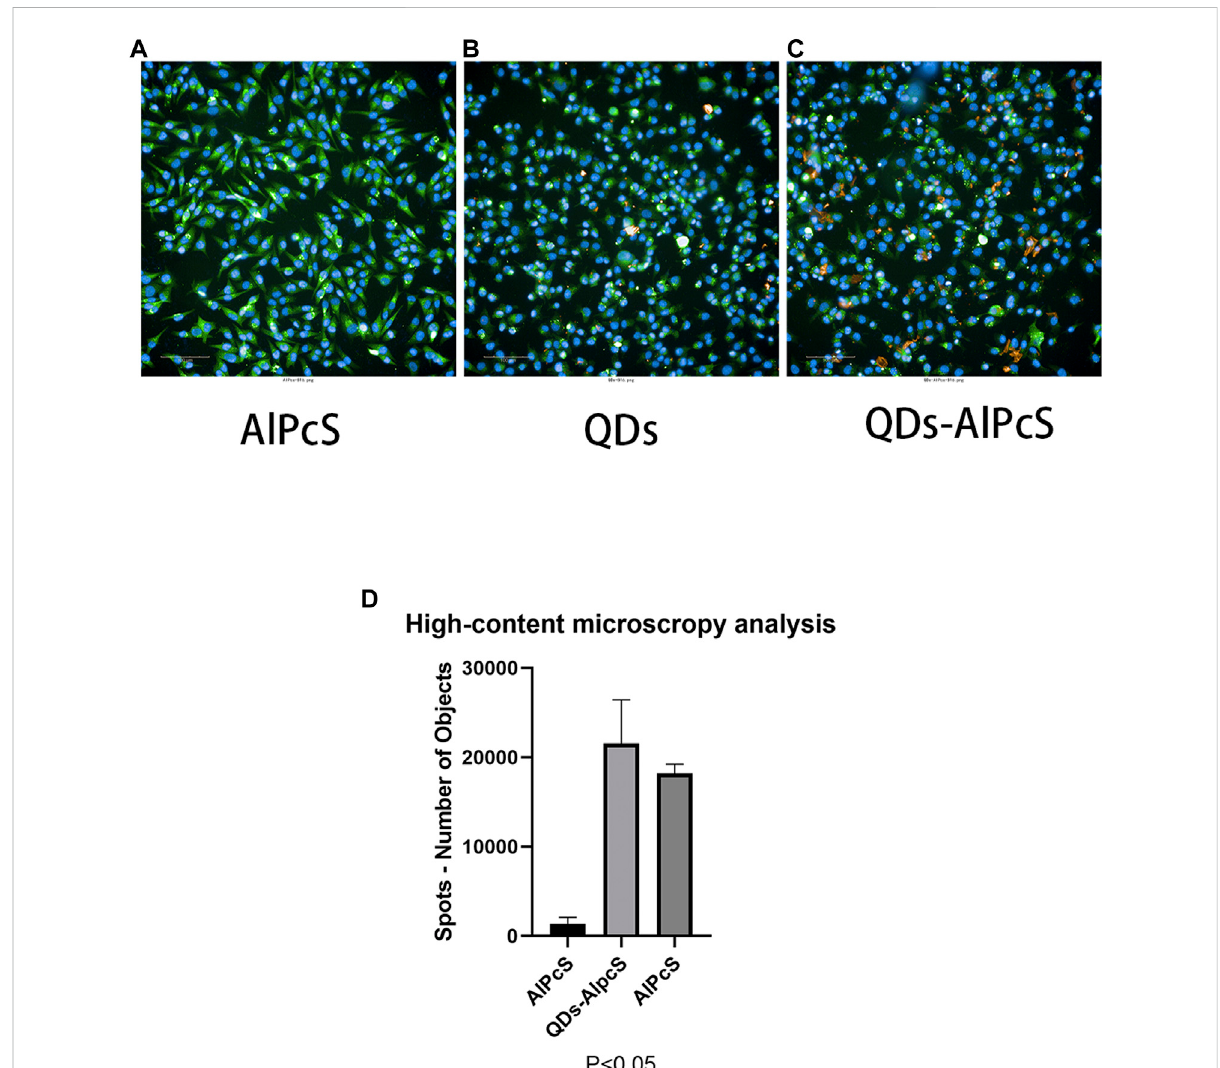
High-contentmicroscopyimagesofB16cellsincubatedfor2 hwithfreeAlPcS (A) ,freeQDs (B) ,andQDs – AlPcS (C) DMEMsolution.Scalebaris 100 um. (D) Totalamountofintracellularred fl uorescencespotsinawellofB16cellswhichwereincubatedfor2 hwithfreeAlPcS(20